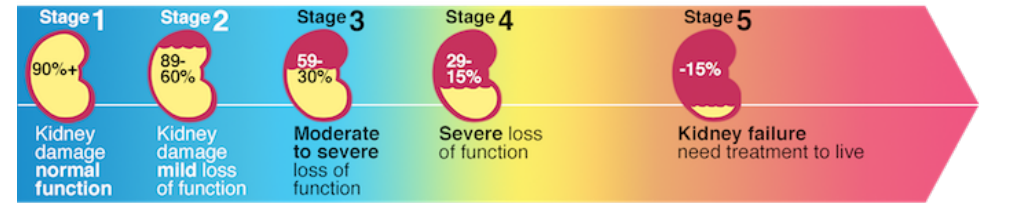
Figure 4. Five stages of kidney